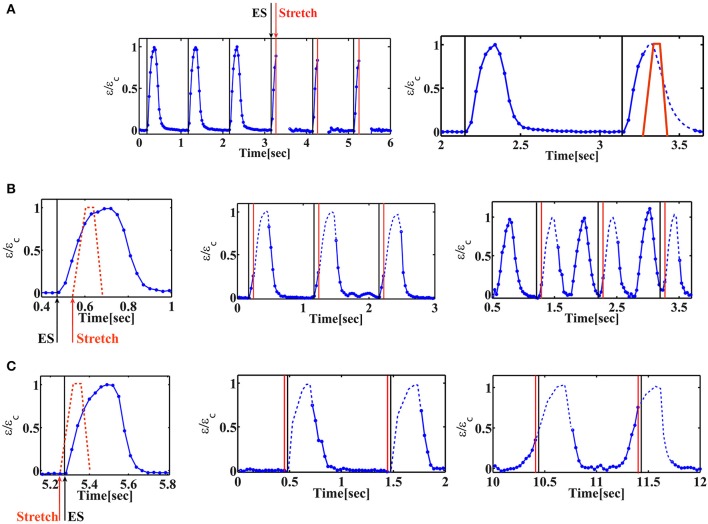
Cardiac cell beating profile under cyclic phase-dependent mechanical loading. Representative beating signals of beating cardiac cells as a function of time for different timings of stretch application. Beating signal was followed by monitoring the displacement of fluorescent beads embedded in the substrate using 40x objective and extracting the strain generated in the substrate. Normalized strain is shown, where εc is the strain at maximal contraction. When the chamber is stretched, the focus is lost. The signal is recovered when the chamber returns to its original position. The missing parts in the beating signal of the cell are added as a dashed line to guide the eye. (A) Left: Beating signal of beating cardiac cells before and during cyclic stretch application. The black lines correspond to the electrical stimulus and the red lines mark the initiation of mechanical stretch. As clearly shown, the beating signal of the cell is lost when the chamber is stretched (after three consecutive contractions). Movie S1 shows the displacement of the fluorescent beads embedded in the underlying substrate. Right: the stretch profile is marked (red “trapezoid”) on top of the beating signal and the “missing part” of the beating signal is shown as a dashed line to guide the eye. (B) Mechanical stretch is initiated 60 ms after the electrical stimulus (ΔtEM /Tcontraction = 0.27). Left: schematic illustration of the timing of mechanical stretch (shown on top of the beating profile before stretch application). Middle: after 1min of continuous cyclic mechanical stretch, no change is observed in the beating profile of the cardiac cell. Movie S2 shows the displacement of the fluorescent beads embedded in the underlying substrate. Right: 20 min after continuous cyclic mechanical stretch, the cell contracts 450 ms before the electrical stimulus (τE/Tcontraction = 1.6). A second contraction is generated following the electrical stimulus. Movie S3 shows the displacement of the fluorescent beads embedded in the underlying substrate. (C) Mechanical stretch is initiated 25 ms before the electrical stimulus (ΔtEM /Tcontraction = −0.1). Left: schematic illustration of the timing of mechanical stretch (shown on top of the beating profile before stretch application). Middle: after 1min of continuous cyclic mechanical stretch, no change is observed in the beating profile of the cardiac cell. Movie S4 shows the displacement of the fluorescent beads embedded in the underlying substrate. Right: 20 min after continuous cyclic mechanical stretch, the cell contracts 240 ms before the electrical stimulus (τE/Tcontraction = 1.25). Movie S5 shows the displacement of the fluorescent beads embedded in the underlying substrate.